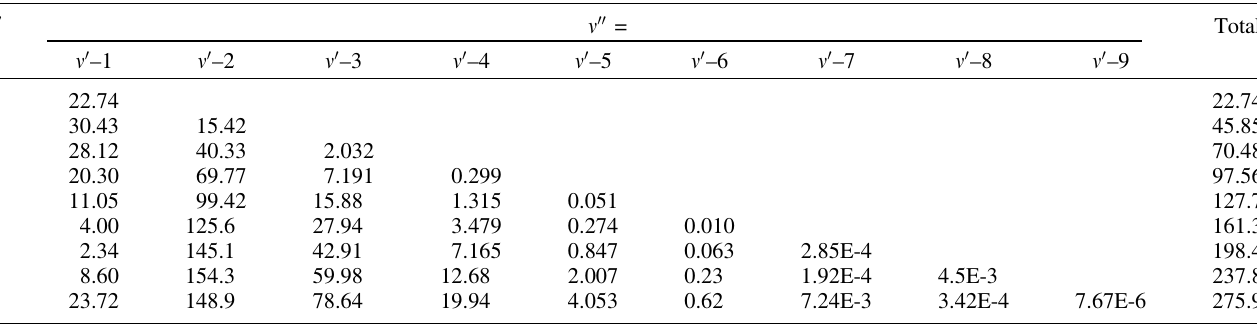
Table A.4. Einstein coef fi cients used in the model to express the reaction coef fi cients between the excited states of OH (from Turnbull & Lowe,